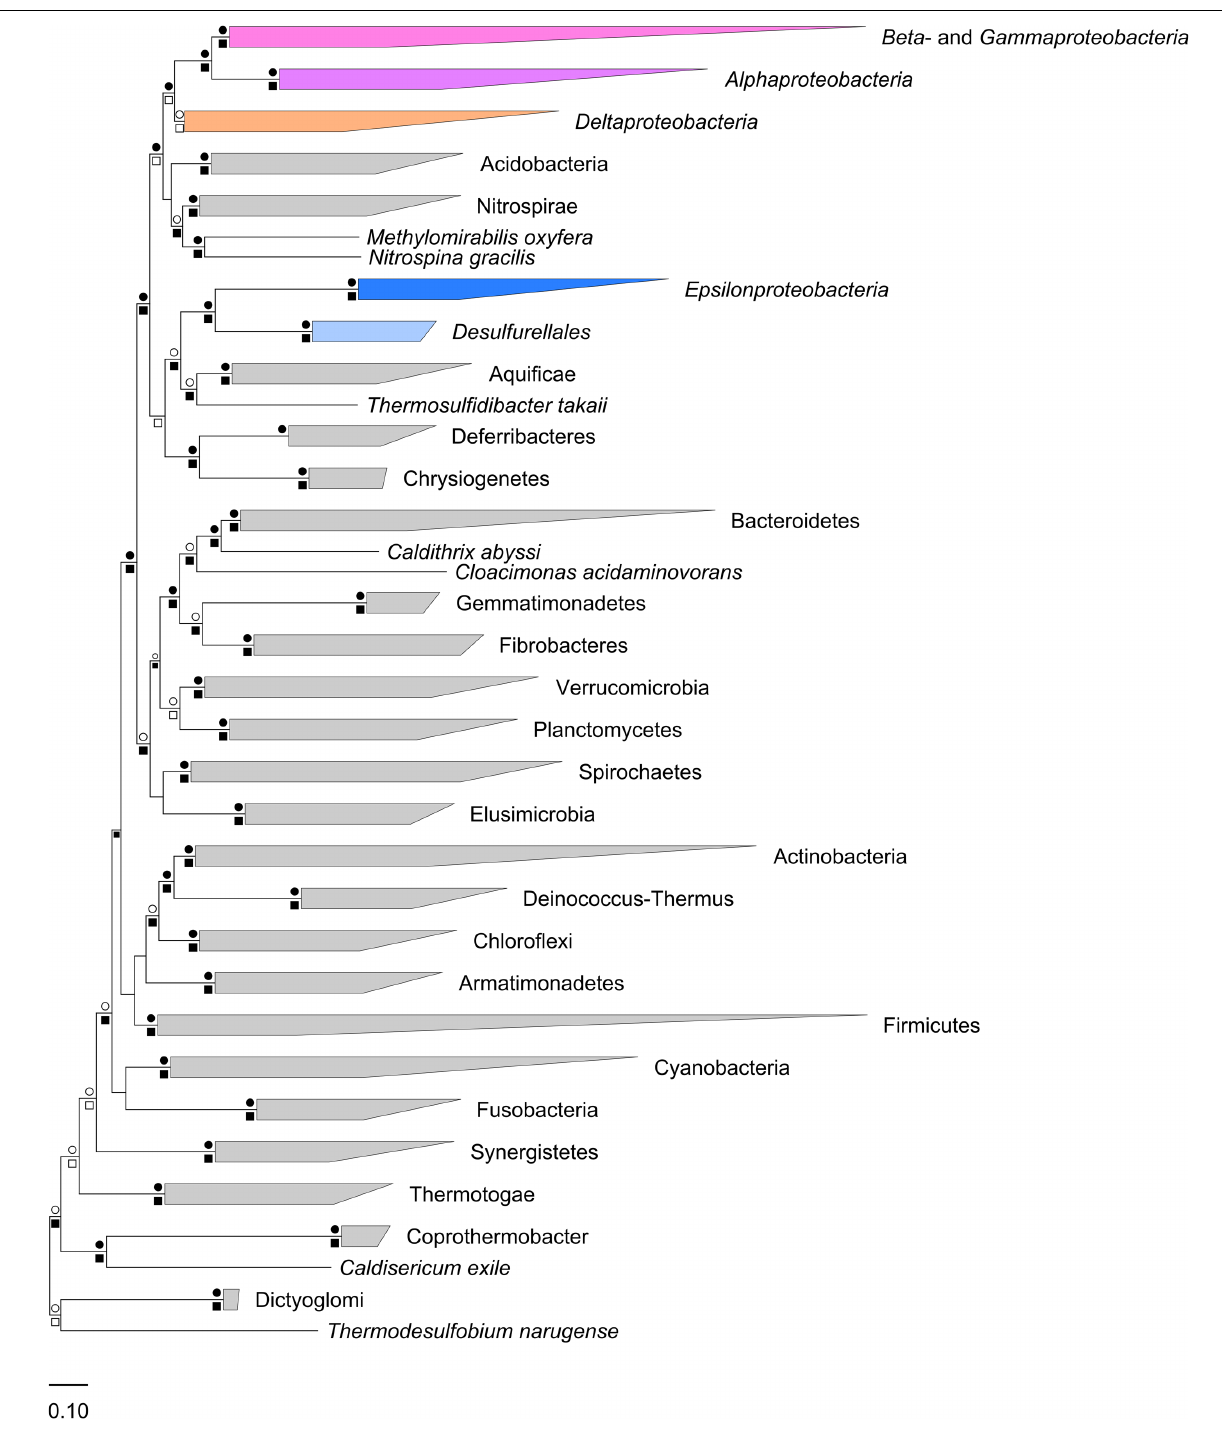
FIGURE 1 | Maximum likelihood phylogenetic inference (WAG + (cid:48) model) of Epsilonproteobacteria and Desulfurellales in the context of 4,170 bacterial genomes and based on 120 concatenated protein sequences. Robustness of the placement of the Epsilonbacteraeota was assessed using bootstrap support and per-phylum jackknifing. Symbols above each branch root (circles) represent bootstrap support of > 90% (black) or ≥ 75% (hollow). Symbols below each root reflect jackknife reproducibility of a node, with black square representing nodes recovered with ≥ 90% support in ≥ 90% of tree topologies. Hollow squares indicate ≥ 75% support in ≥ 90% of topologies. Under every tree topology explored Epsilonproteobacteria and Desulfurellales were recovered as a strongly supported monophyletic group with no association to the remaining Proteobacteria. Key findings of tree topologies under alternate tree building models are summarized in Table 1